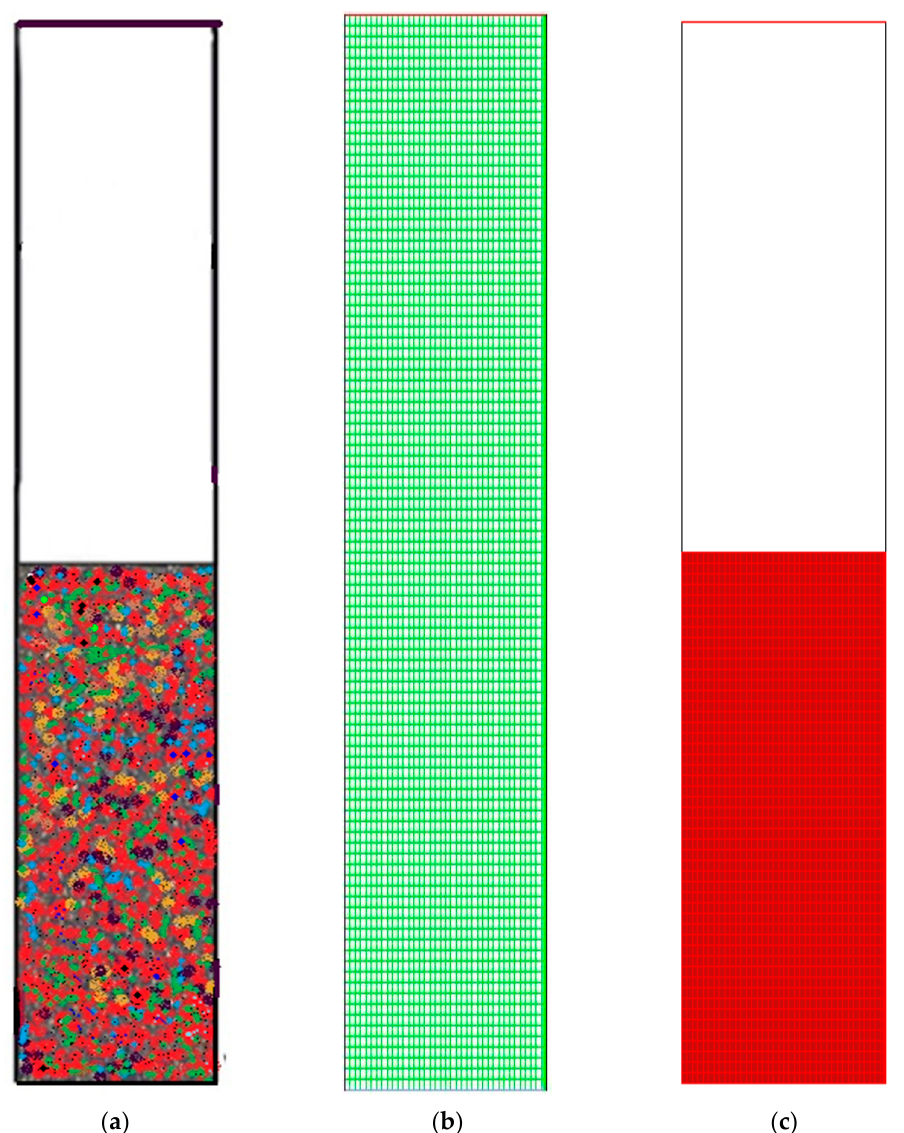
Figure 7. General computational domain and mesh generation. ( a ) Framework of the gas-phase fluidised bed polymerisation reactor used in simulation; ( b ) Generated Mesh for fluidised bed simulation; ( c ) Computational region marked.